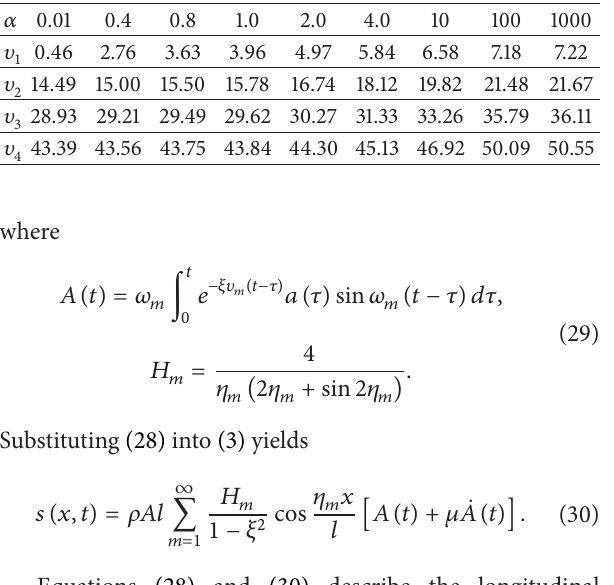
Table 2: The first four-order natural frequency.